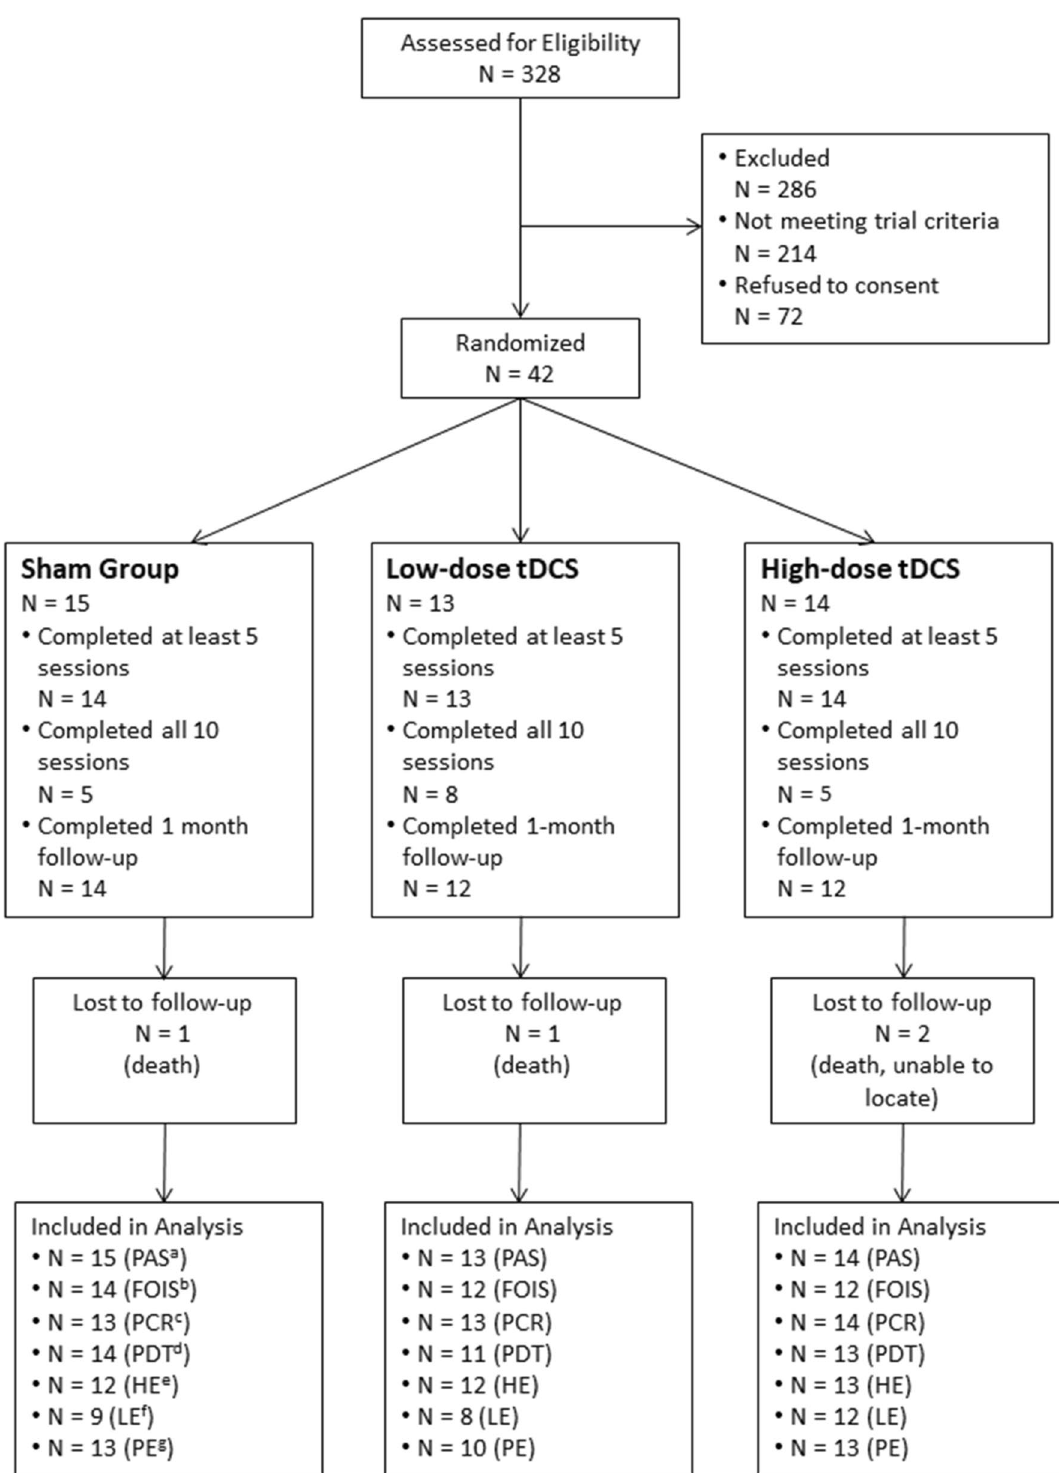
Figure 2. Consort flow diagram showing progress of subjects in the trial Sham and anodal transcranial direct stimulation (atDCS) Groups. (a-Penetration and Aspiration Scale; b-Functional Oral Intake Scale; c-Pharyngeal Constriction Ratio; d- Pharyngeal Delay Time; e-Hyoid Excursion; f-Laryngeal Excursion; g-Pharyngeal